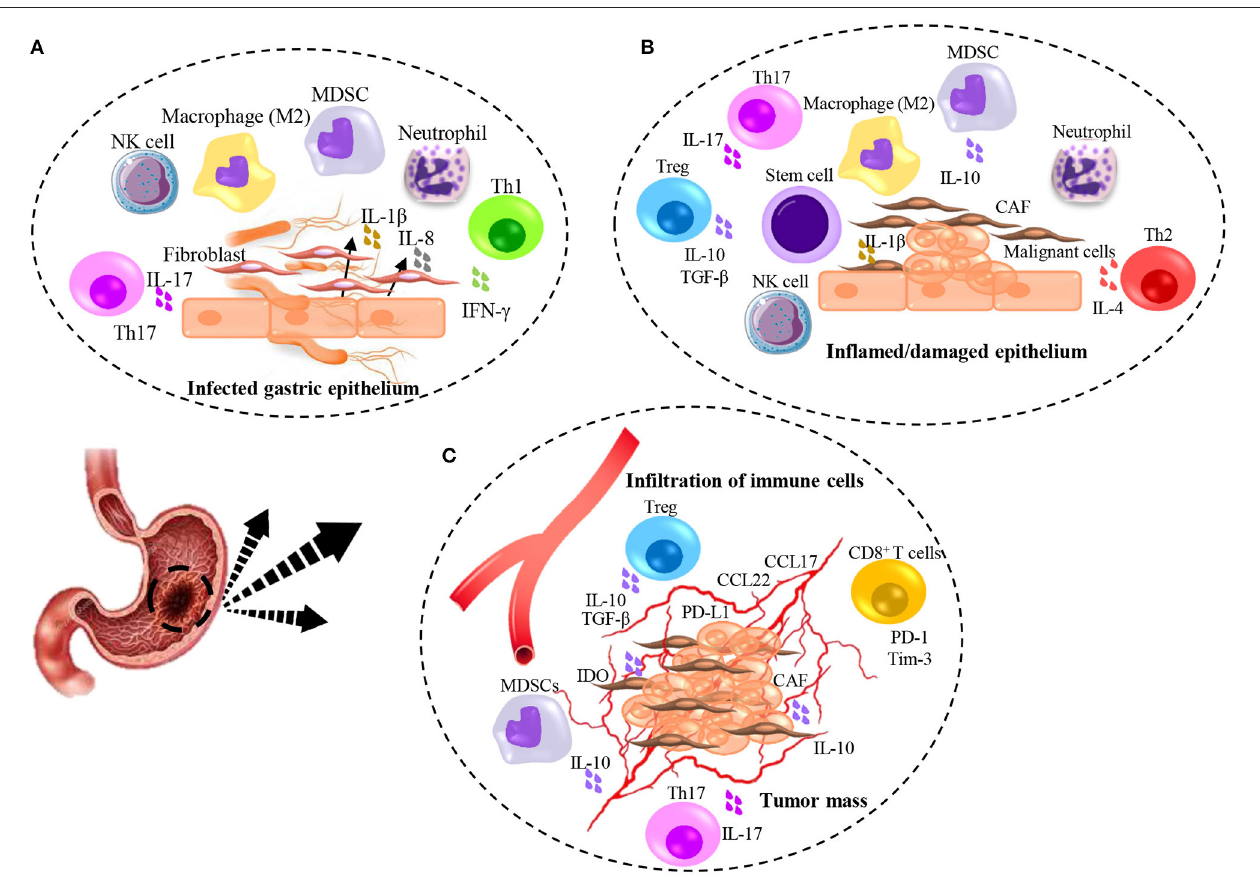
FIGURE 1 | Illumination of immunomodulation induced by H. pylori infection and gastric cancer. (A) H. pylori-induced inflammation contributes to initiate damaging of gastric epithelial cells and production of inflammatory cytokines leading to the immediate response of Neutrophils, Macrophages, NK cells, MDSCs, and recruitment of fibroblasts from the bone marrow. Contribution of T cell subsets specifically Th1, result in partial but not complete elimination of bacteria. (B) Chronic inflamed/damaged epithelium promotes atrophy. Continued inflammation with the activity of Th1 and Th17 leads to the emergence of Th2 cells that causes tissue remodeling and promotes dysplasia. Production of TGF- β mainly by Treg cells accompanied by IL-6 result in the recruitment of stem cells and differentiation of CAFs which help to initiate the malignancy. (C) Tumor angiogenesis contributes to the infiltration of immune cells and promotes tumor growth. The secretion of IL-17 from Th17 cells leads to an increase in the angiogenesis and the further recruitment of suppressor immune cells through chemokines secreted by tumor cells. Further immunosuppressive activity is caused by the expression of co-inhibitory molecules by tumor cells and the secretion of suppressive